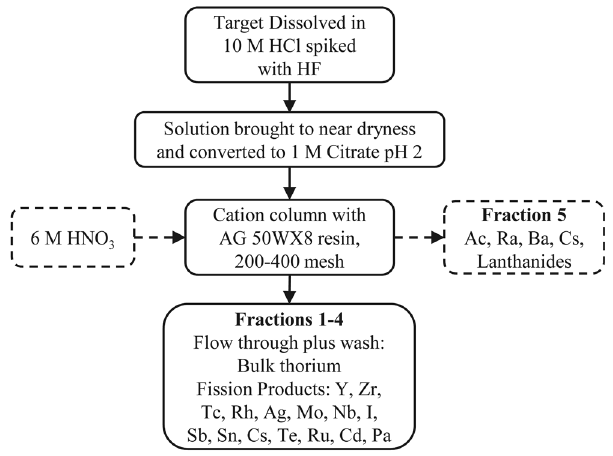
Figure 1. Cation Exchange